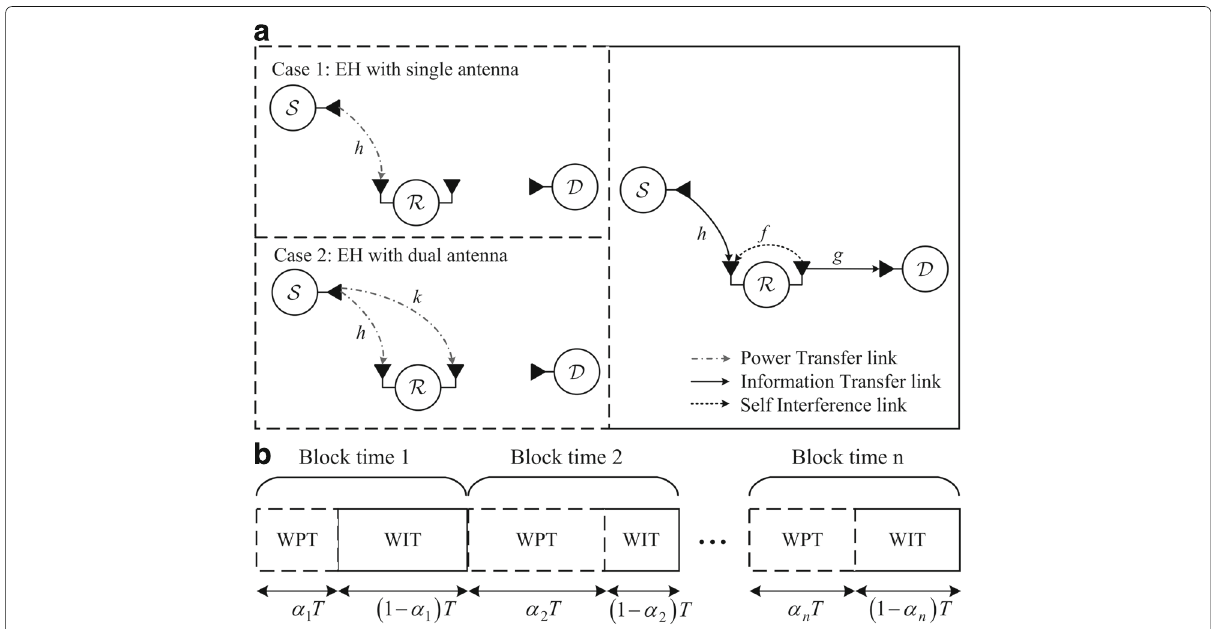
Fig. 1 Two-hop relaying networks in full-duplex communication with SWIPT. a Describing two phases of cooperative relay energy harvesting communications with two scenarios of energy harvesting at relay node. b TSAC protocol for energy harvesting full-duplex relaying network